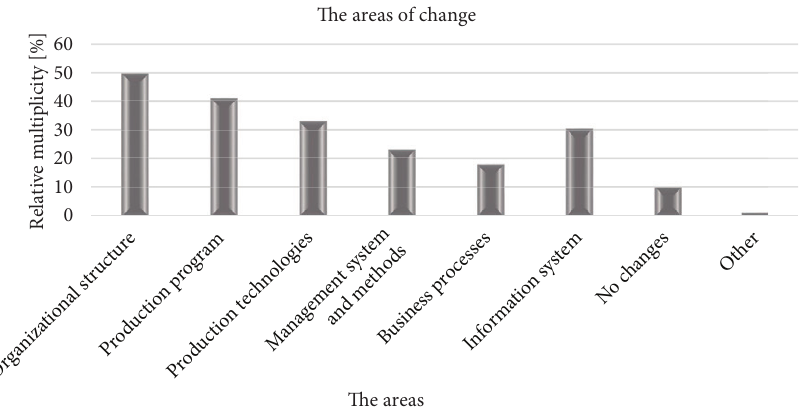
Figure 1. Areas of change (source: own processing)